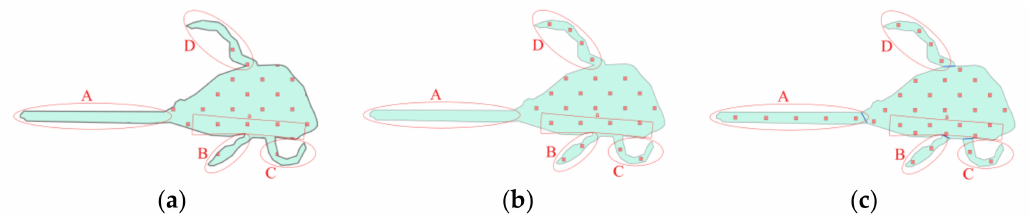
Figure 10. Complex area 2 (the blue solid line is the segmentation line). ( a ) Filling using the traditional three-square type method. ( b ) The effect of the filling method based on simple segmentation. ( c ) The effect of the method proposed in this paper.